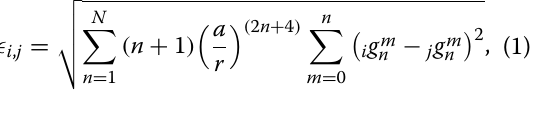
Table 3 Number of data (vector triples counted as one) by type, and the mean and root-mean-square (RMS) misfits between model and data